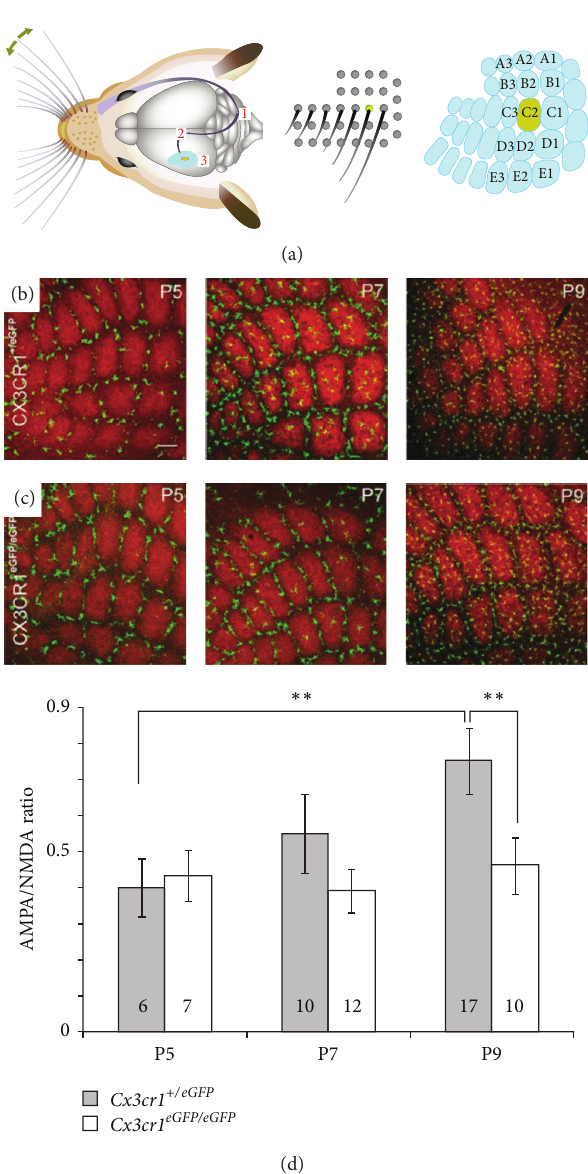
Figure 3: Fractalkine/CX3CR1 signaling controls the recruitment of microglia and the functional maturation of thalamocortical synapses. (a) Drawing of the sensory system of vibrissae in rodents and link between the distribution of vibrissae and that of barrels in layer 4 somatosensory cortex. Adapted from [59]. ((b) and (c)) Microglia (green) distribution in the layer 4 of the somatosen- sory cortex during postnatal development in Cx3cr1 +/eGFP (b) and Cx3cr1 eGFP/eGFP (c) mice. At P5, microglial cells are exclusively located outside of the barrel centers which contain thalamocortical synapses (red, staining of thalamocortical axons). At P7, microglial cells start to invade the barrel centers in Cx3cr1 +/eGFP mice and this invasion is delayed in Cx3cr1 eGFP/eGFP mice. At P9, microglial cell distribution is similar for the two genotypes. Scale bar, 100 𝜇 m. (d) Relative change in the synaptic currents resulting of the